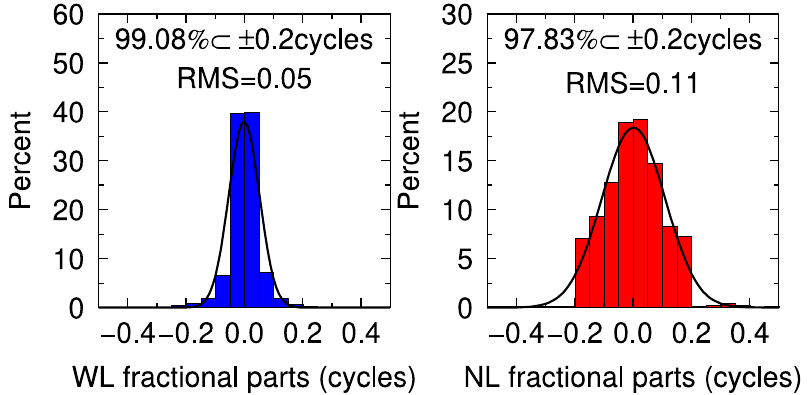
Figure 4. Distribution of the fractional parts of all the WL and NL ambiguities for the PPP method on DOY 002-003.